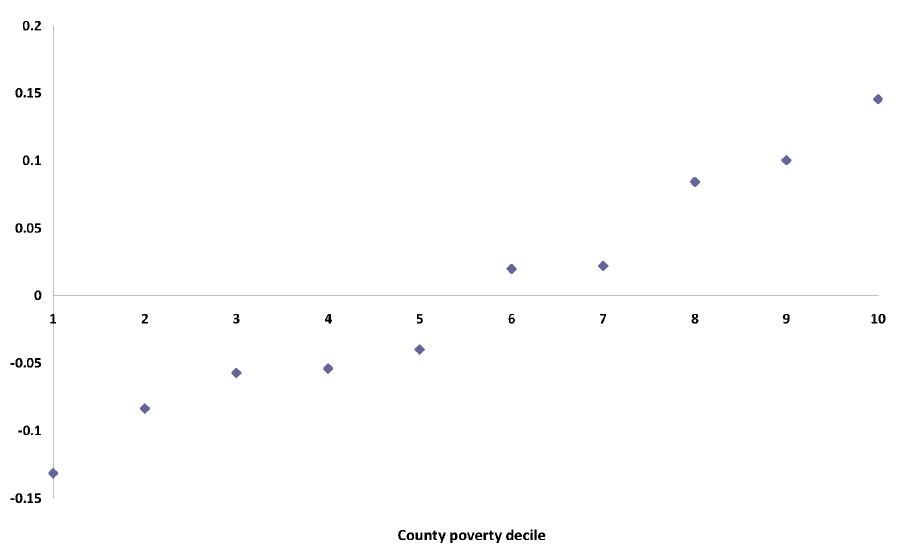
Figure 4 . Total latent area effect, model 1, by county poverty